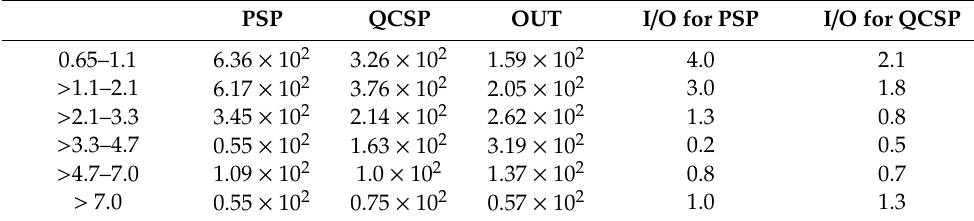
Table 2. Average concentration and indoor / outdoor ratio (I / O), CFU / m 3 of bacterial colony-forming units per cubic meter collected from the di ff erent stages of ACI in the preliminary manual sorting cabin (PSP), purification manual sorting cabin (quality control) (QCSP), and outside the analyzed building